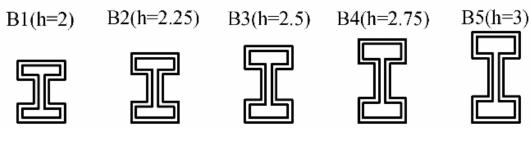
Figure 14. Cellular structures of different sizes of h